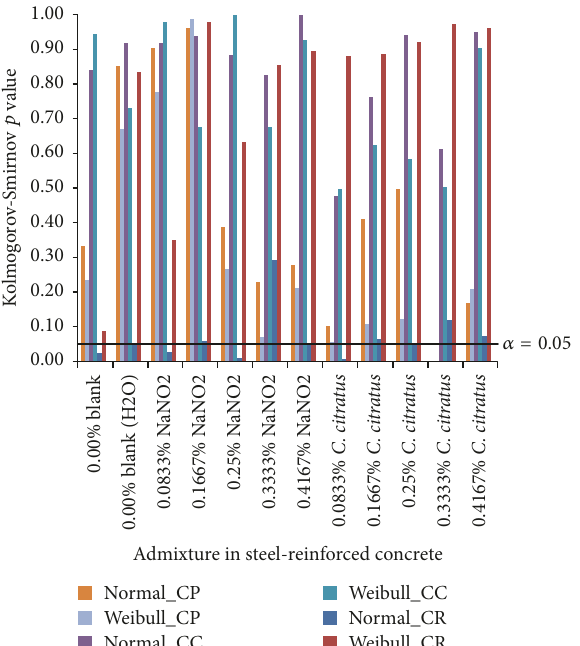
Figure 2: Kolmogorov-Smirnov goodness-of-fit tests of corrosion datasets scattering like the Normal and the Weibull distribution.